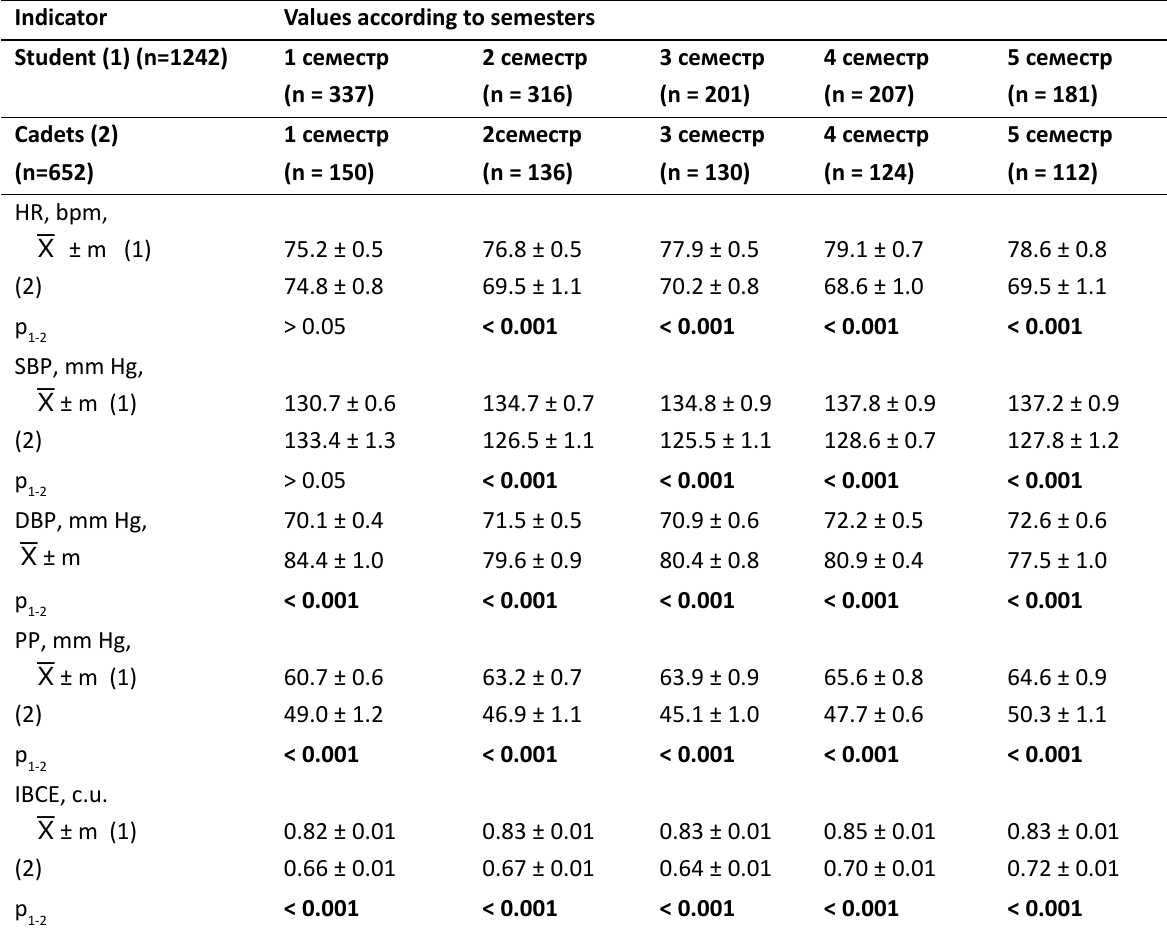
Table 2. Characteristics of the functional condition of students (1) and cadets (2) in different semesters of study Indicator Values according to